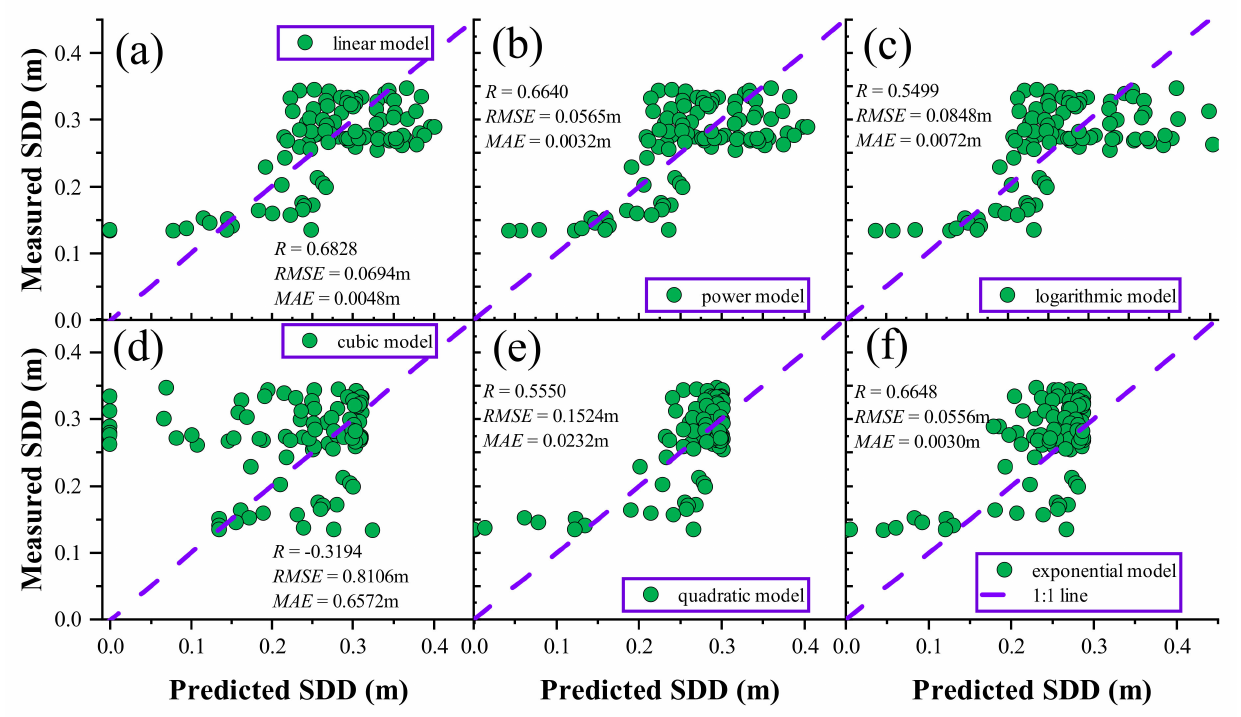
Figure 4. Validation of the accuracy of the inversion models, including ( a ) linear; ( b ) power; ( c ) loga- rithmic; ( d ) cubic; ( e ) quadratic and ( f )